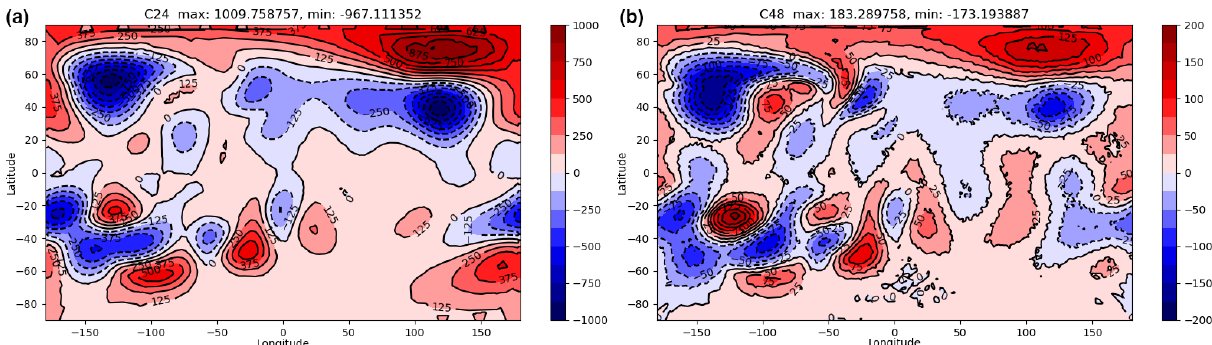
Figure 6. Absolute error plots for total geopotential ( (cid:56) + (cid:56) s ) for the Williamson mountain test on the C24 grid (a) and the C48 grid (b) after 15d. Note the different scales on the colour